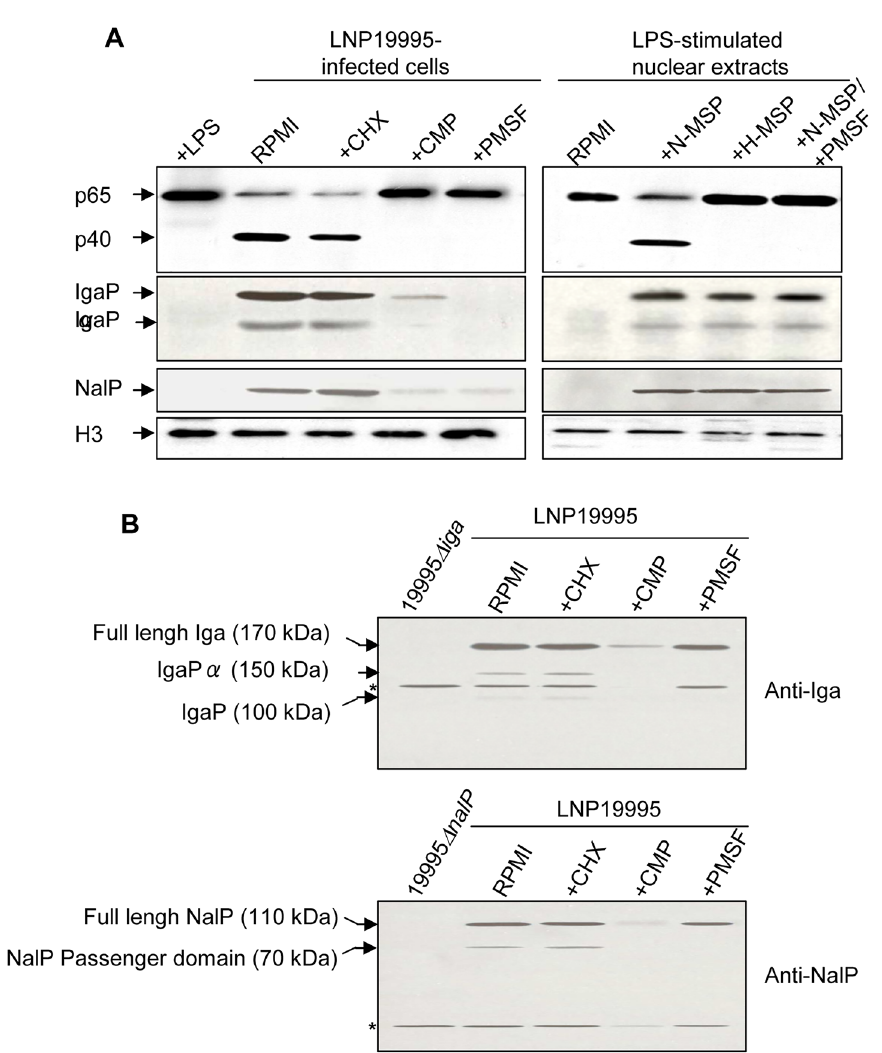
Fig 2. Nuclear cleavage of p65/RelA is carried out by a ST-11 meningococcal secreted serine protease. (A) For in vivo experiments (left panel), Hec-1B cells were infected for 9h in absence or presence of 1 μ g.ml -1 cycloheximide (CHX), 5 μ g.ml -1 chloramphenicol (CMP) or 5 mM PMSF. After incubation cells were harvested, and nuclear fractions were prepared. For in vitro experiments (right panel), nuclear extracts were prepared from LPS-stimulated cells and then incubated with native meningococcal secreted proteins (N-MSP) in absence or presence of 5 mM PMSF, or heat-inactivated MSP (H-MSP) of the ST-11 isolate LNP19995. Samples were resolved by SDS-PAGE and immunoblotted with anti-p65/RelA mAb, anti-IgA protease or anti-NalP sera.Histone H3 expression (lower panel) was used as loading control. Immunoblot is representative of three independent experiments which yielded similar results. (B) Whole lysates of bacteria recovered from (A), were resolved by SDS-PAGE and immunoblotted with anti-IgA protease or anti-NalP sera.Mutant strains 19995 Δ iga and 19995 Δ nalP were used as negative controls. Full length precursors and autocleaved forms are indicated by arrows. * represent a cross reactive